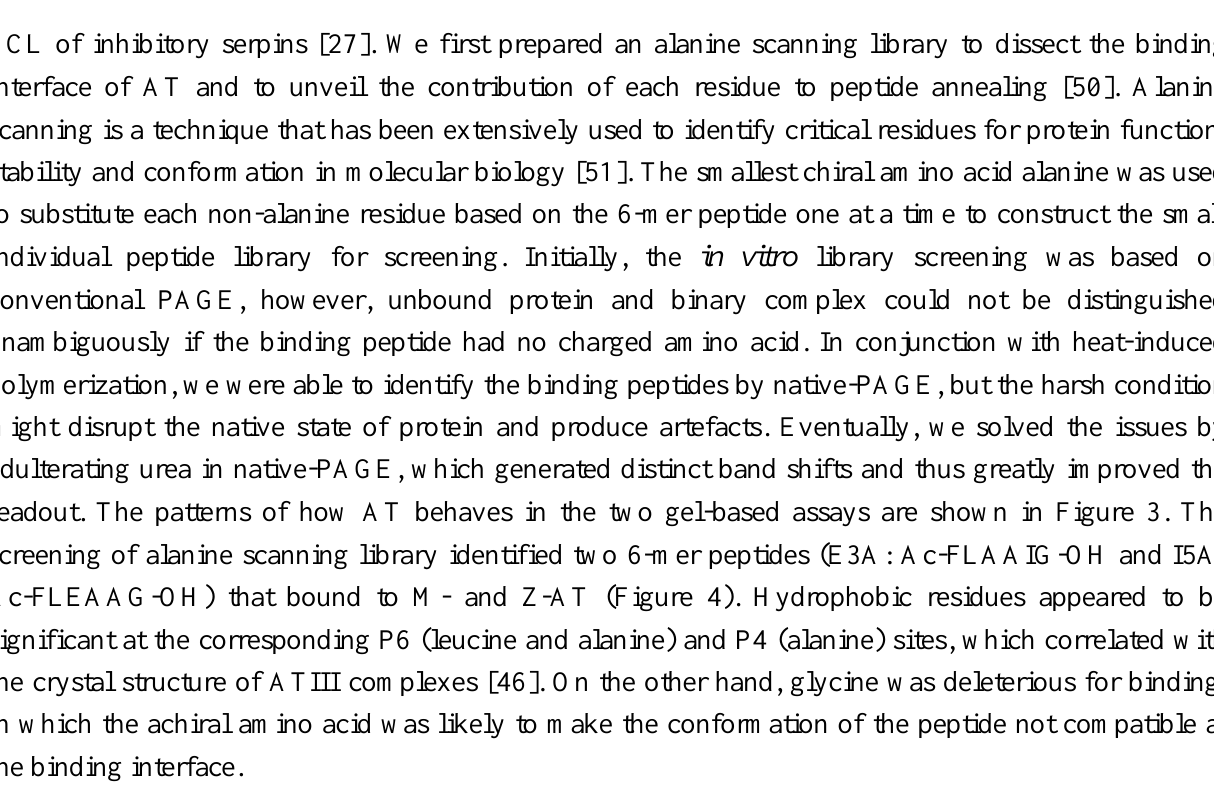
Figure 3. Gel patterns of polymerizing α -antitrypsin (AT). 8% ( w/v ) native-PAGE (left) 1 and 8% ( w/v ) 8 M urea native-PAGE (right) demonstrating the patterns of heat-induced polymerization of M-AT (4 μg, heated at 58 °C) at 0 (lane 1), 1 (lane 2), and 4 (lane 3) h. The native protein (N), short-chain (S), and long chain (L) polymers of AT are marked in the